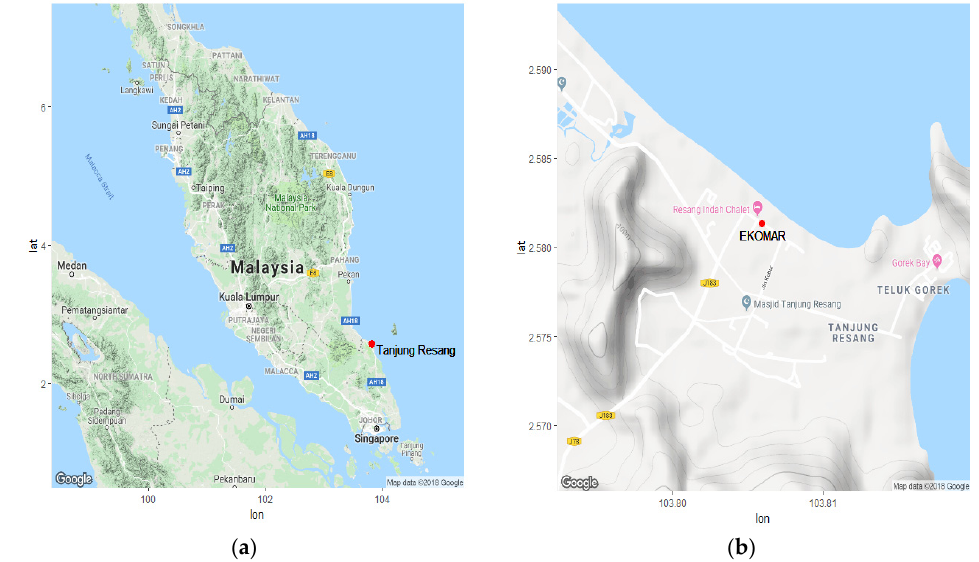
Figure 8. ( a ) Map of Malaysia where the red dotted point indicates the location of Kampung Tanjung Resang. ( b ) Map of Kampung Tanjung Resang where the red dotted point indicates the location of EKOMAR (source: Google [62]).